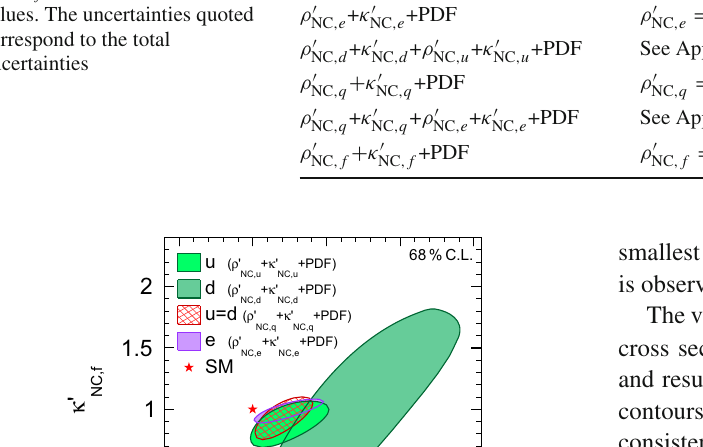
Table 4 Results for ρ (cid:6) and Fit parameters Result NC κ (cid:6) parameters and their NC correlation coefficients. The parameters α , m W , m Z , m t , m H and m f are set to their SM values. The uncertainties quoted correspond to the total uncertainties